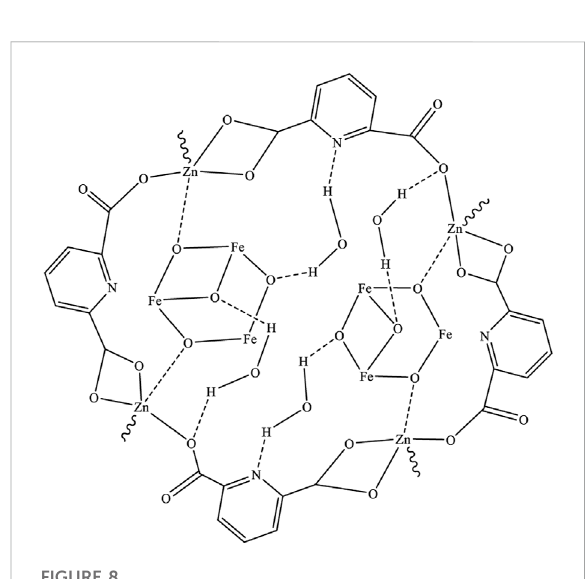
FIGURE 8 Proposed structure for Fe 3 O 4 /Zn-metal organic framework magnetic